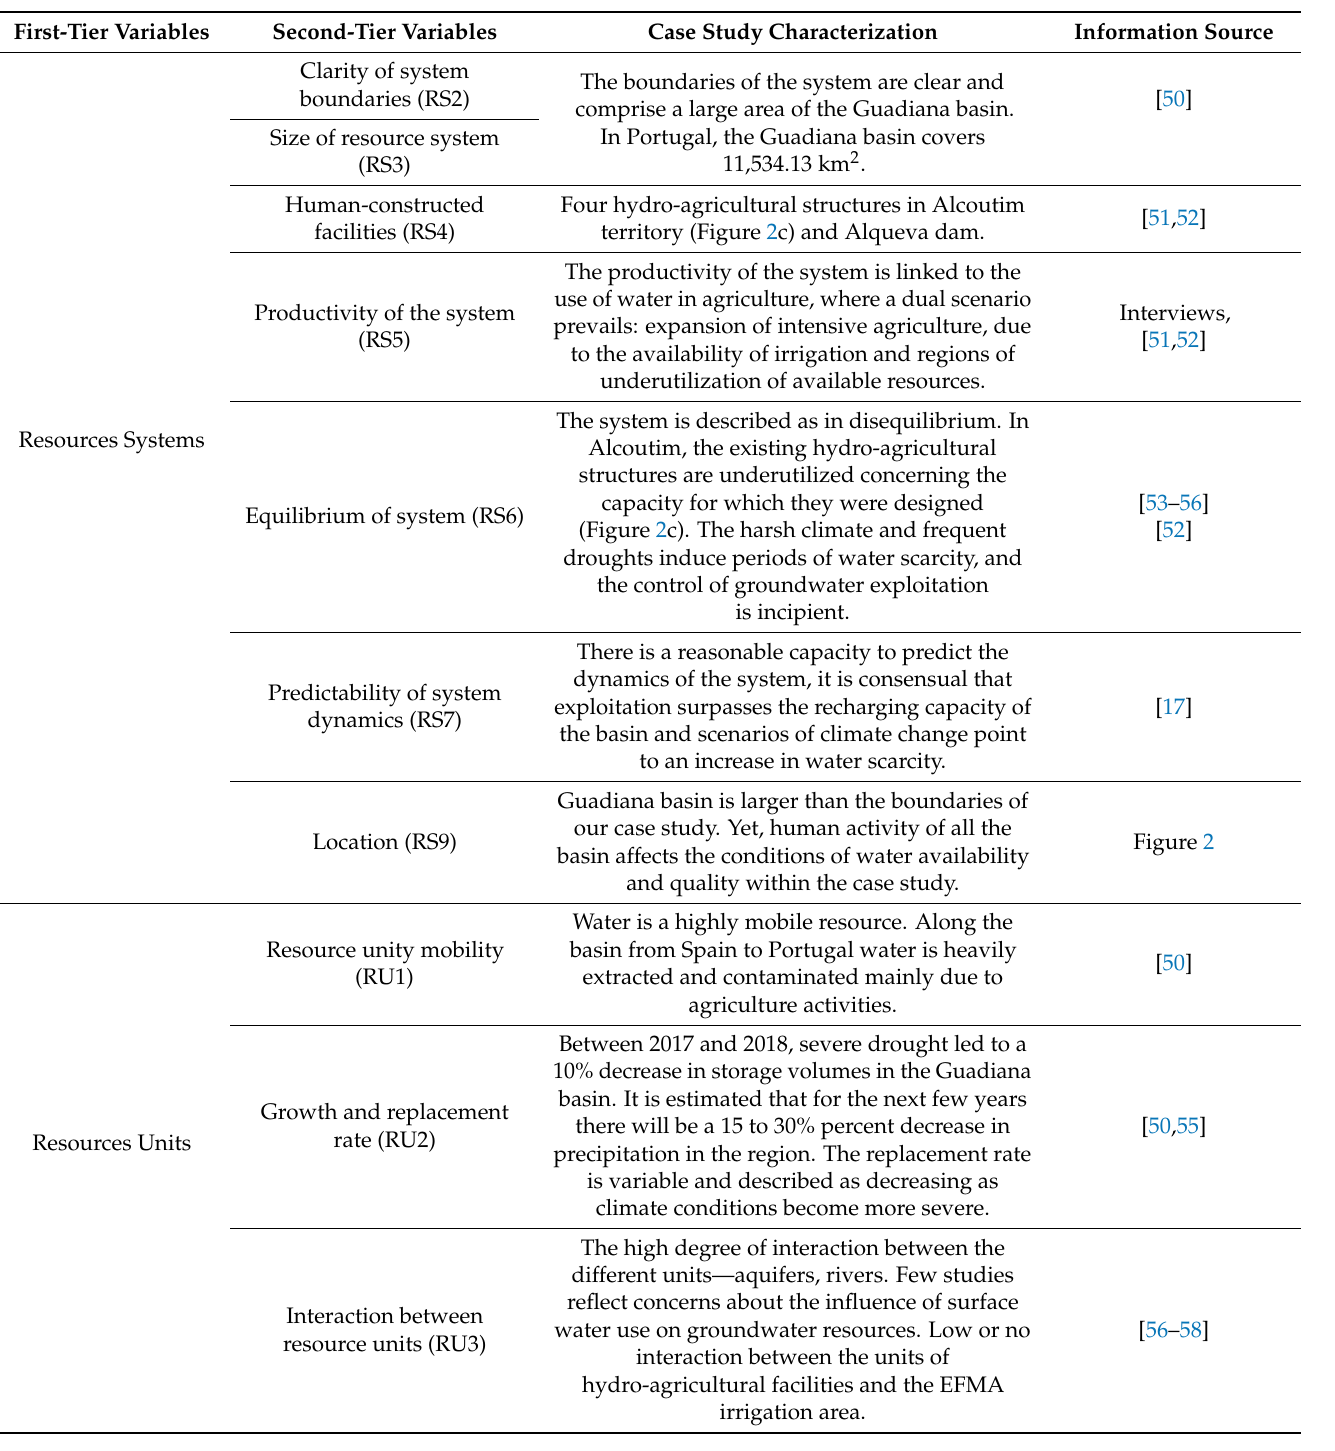
Table 1. Characterization of second-tier variables in the case